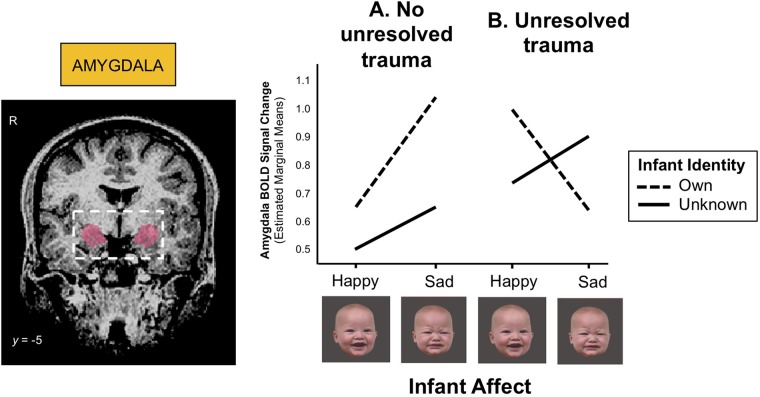

(A) Mothers with no unresolved trauma show a greater amygdala response to sad than happy infant faces (z = 3.00, p = 0.003), whereas (B) mothers with unresolved trauma show a blunted amygdala response to their own infant’s distress cues during functional MRI scanning (z = -2.38, p = 0.017). BOLD (blood-oxygen-level-dependent) signals were extracted from a bilateral amygdala mask (shown left) and submitted to mixed-effects linear regression analysis. Adapted from (138). Used with permission from Taylor & Francis Ltd.